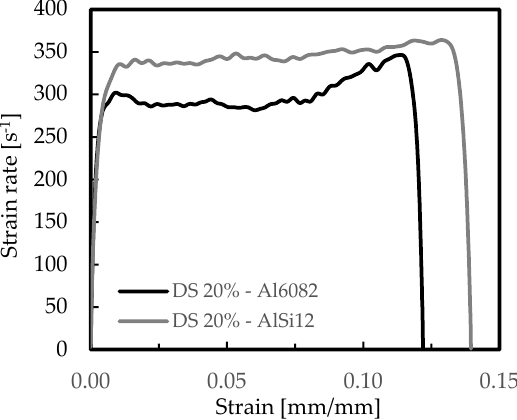
Figure 3. Strain rate-strain curves for the Al6082-T4 and AlSi12 foams for DS 20%.